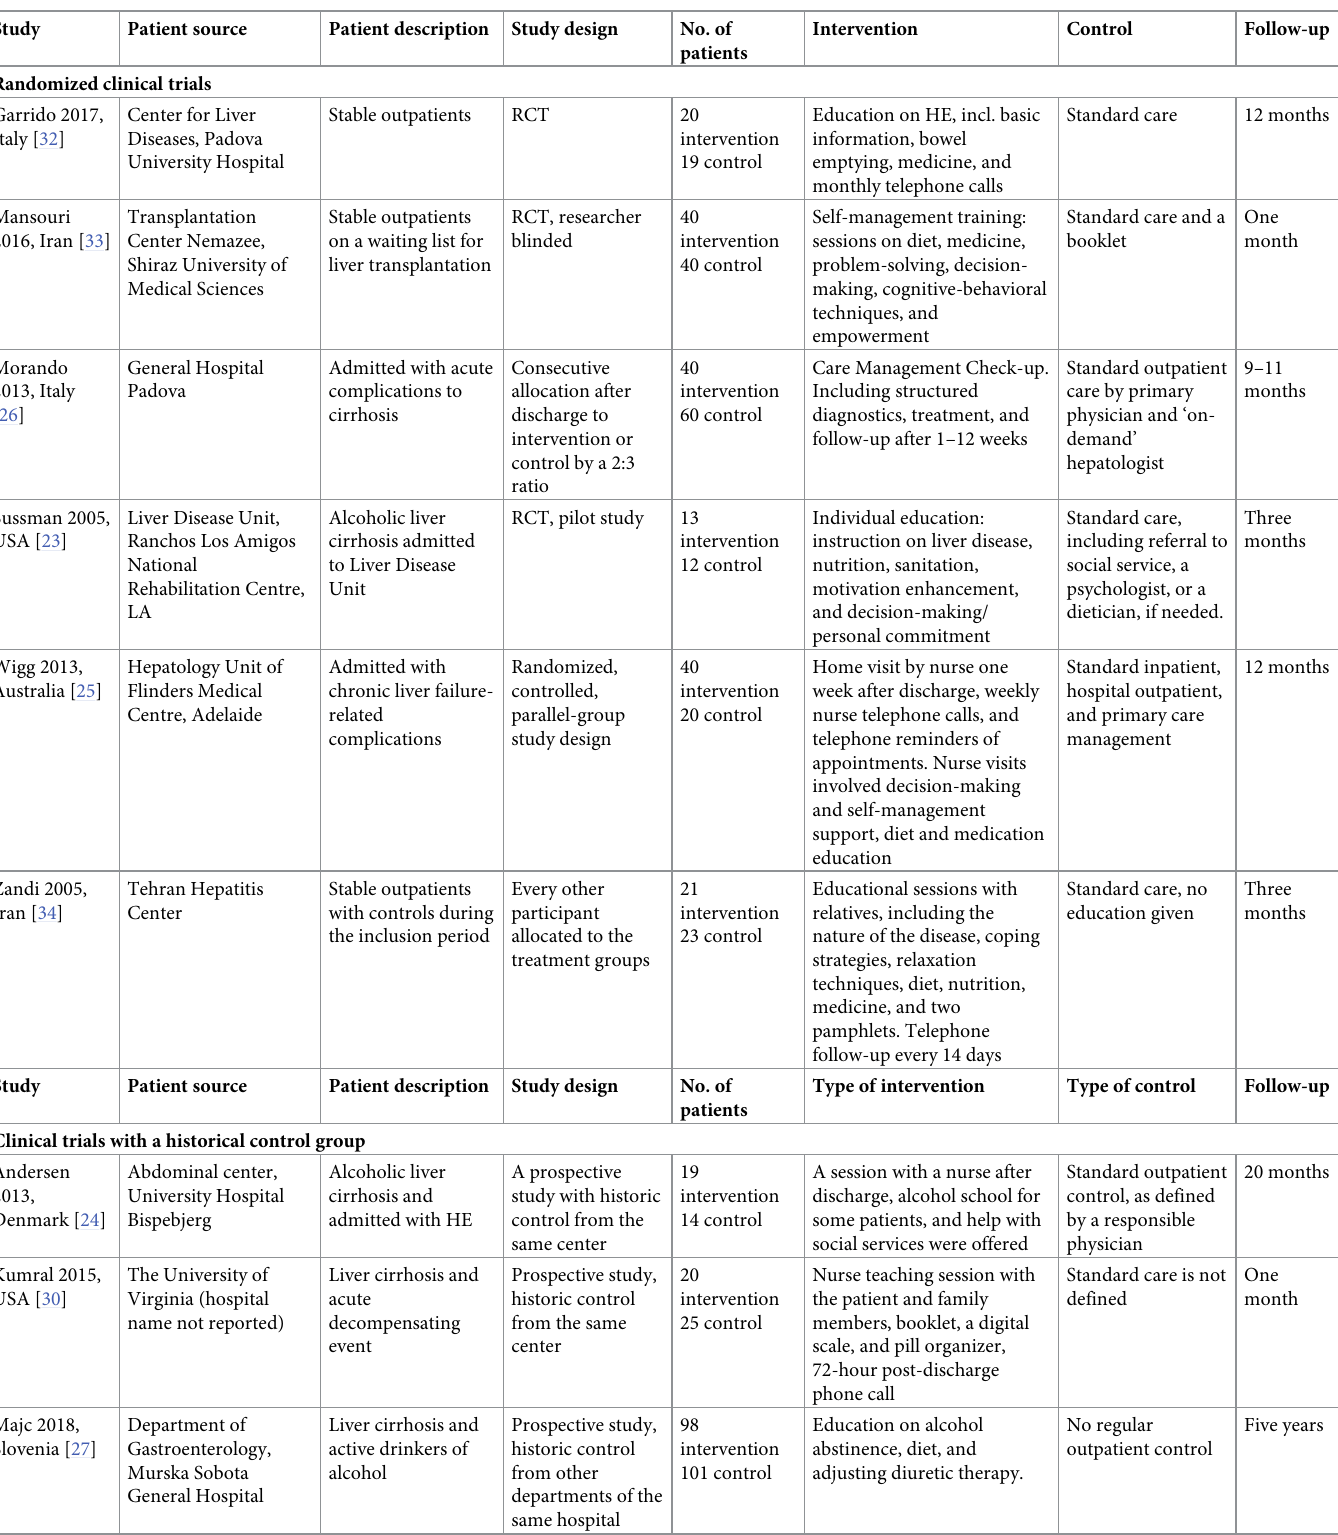
Table 1. Characteristics of the 16 included